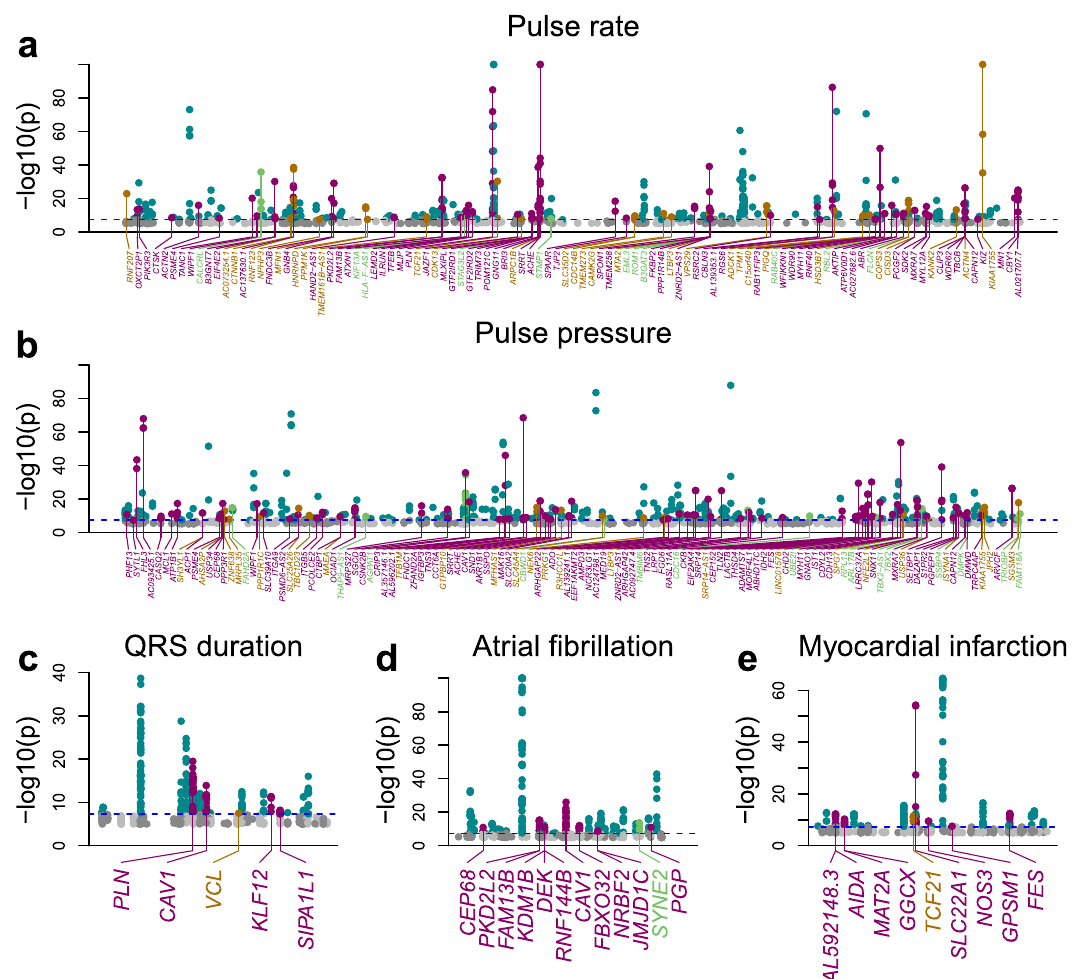
Fig. 4| Manhattanplotsshowing theGWASsignalsthatcolocalizewitheQTLs. a – e Manhattan plots showing the GWAS signals for fi ve cardiac traits. Among all genome-wide signi fi cant SNPs, the GWAS signals that colocalize with eQTLs for eGenes are highlighted in purple, with eQTLs for eIsoforms (light brown), with